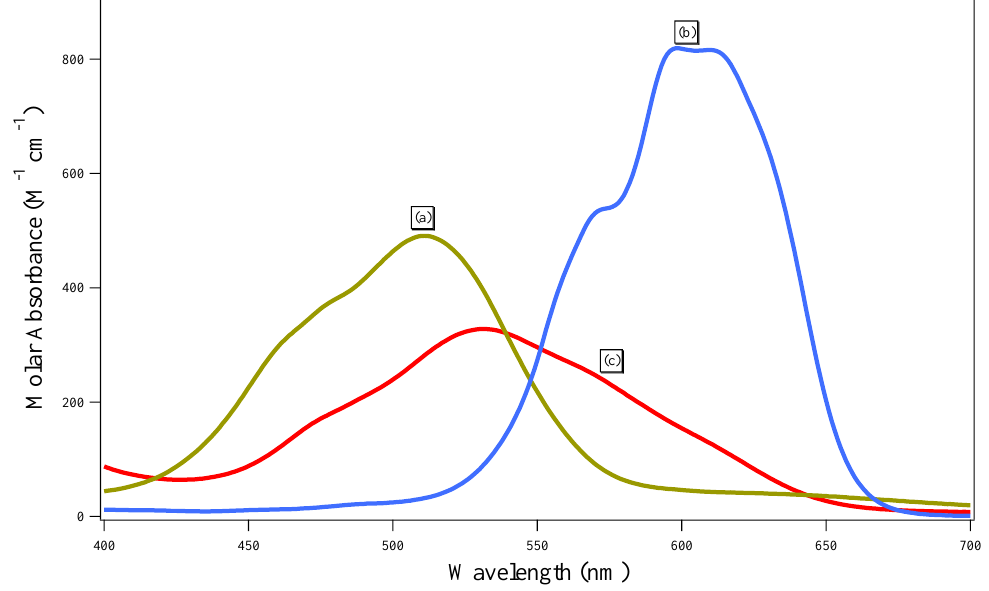
Figure 6. UV-Vis spectra of Co.(NO 3 ) 2 in ( a ) BuNC 2 OC 8 -Dca phase; ( b ) aqueous phase step up 100 times and; ( c ) BuNC 2 OC 8 -ClSal phase step up 10 times. C metal = 0.05 mol L −1 ; V w = 2 mL; m Il = 0.5 g; UV-vis spectra are recorded in ethylacetate for IL